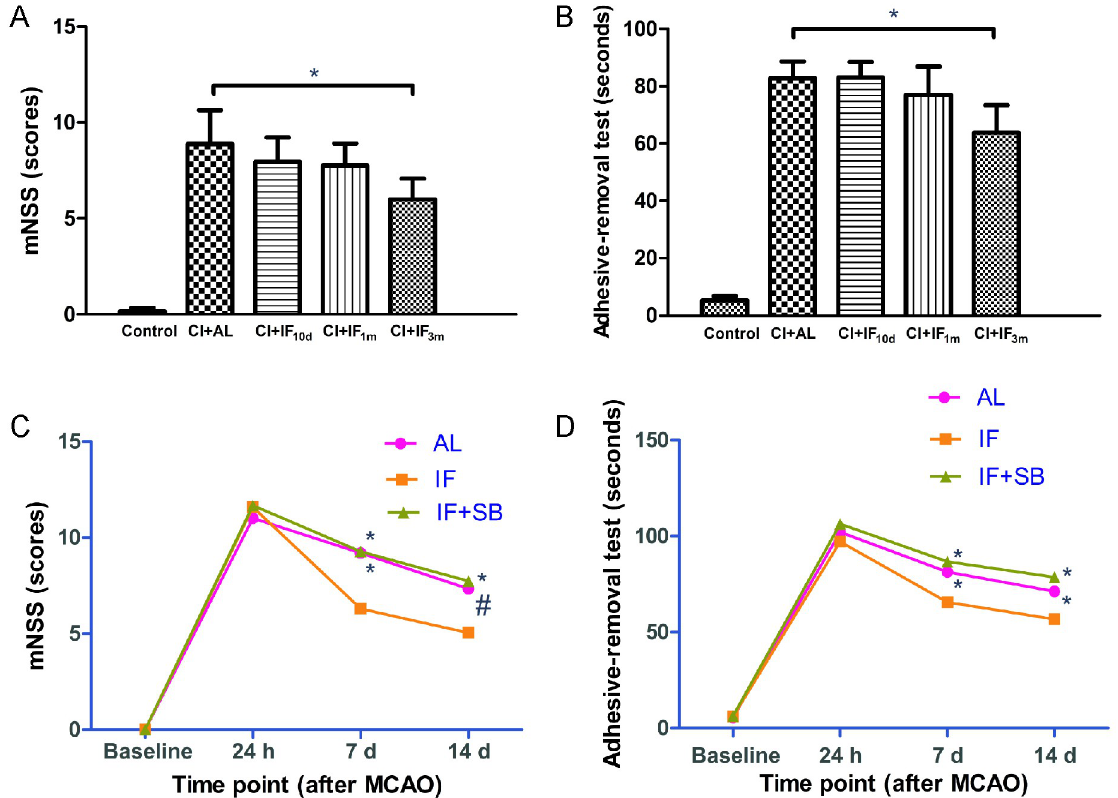
Fig 1. Neurological function assessment results in each group. mNSS ( A ) and adhesive removal test ( B ) results in different dietary regimens of the 5 animal groups from the first step of this study 7 d after CI (n = 8/group). * p < 0.01, compared with the CI+AL group. mNSS ( C ) and adhesive removal test ( D ) results in different time points of 3 groups from the second step of this study (n = 16/group). # p < 0.05, * p < 0.01, compared with the IF group at the same time